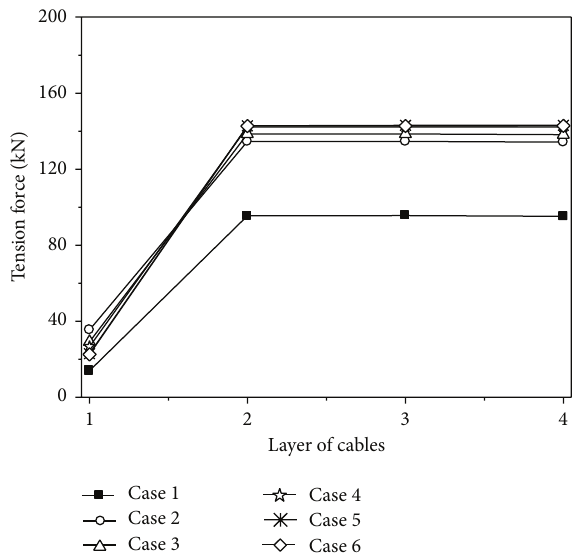
Figure8:Verticaldisplacementsofthecableunderdifferentdegrees of coherency loss. Figure 9: Tension forces of the cables under different degrees of coherency